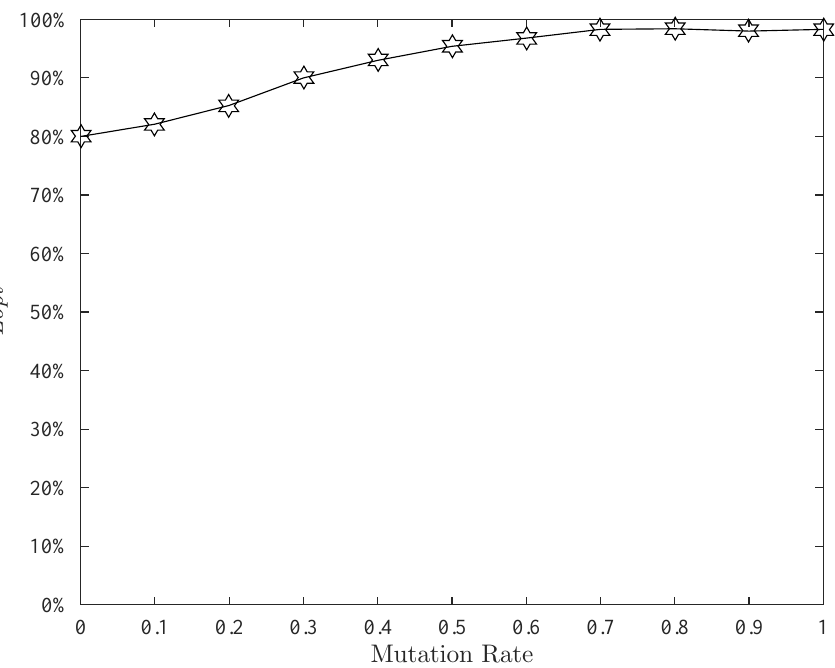
Figure 20. Effect of the insert operator rate.